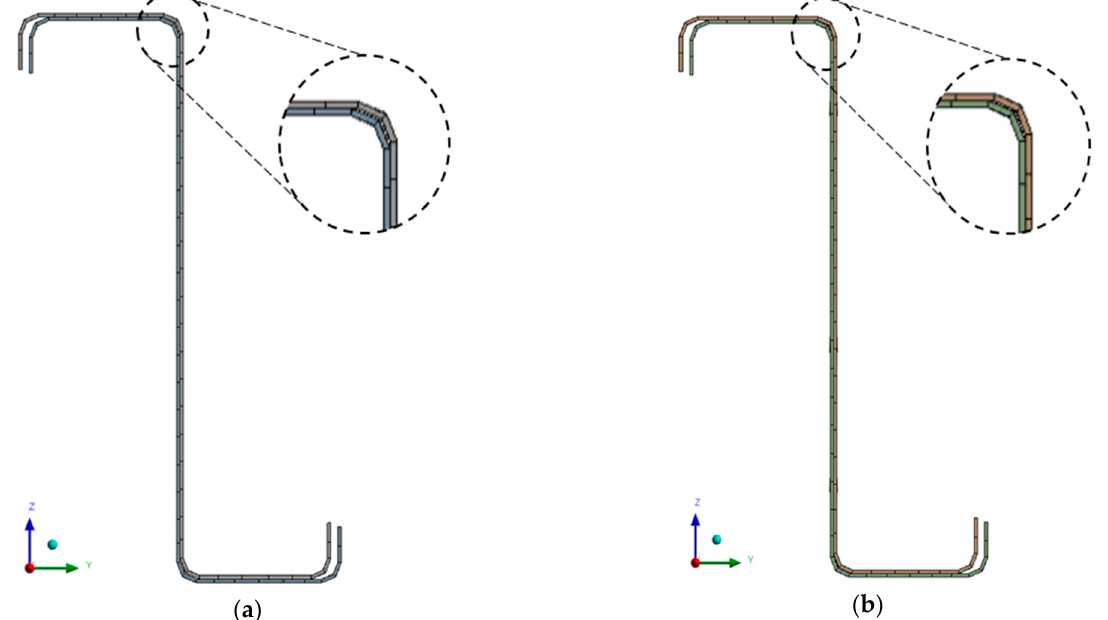
Figure 6. Comparison of finite element mesh of a pair of thin-walled purlins: ( a ) SOLSH190, ( b ) SOLID181.